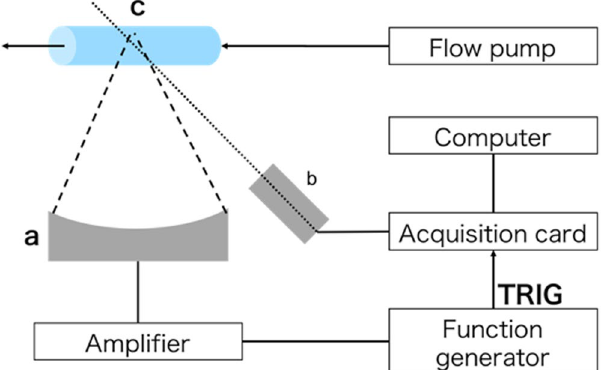
Figure 2. Schematic of experimental setup for cavitation detection. a: Emission transducer. Two different transducers were used: 3.34 and 5.39 MHz. b: Passive cavitation detector. c: Bubbles are circulating at controlled flow speed in acoustically transparent tube placed in focal zone of emission